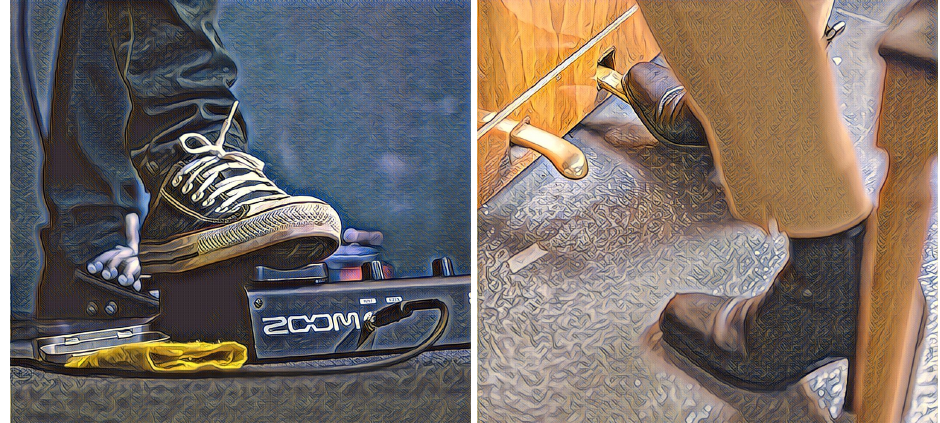
Figure 5. Illustrations of an interaction style using foot